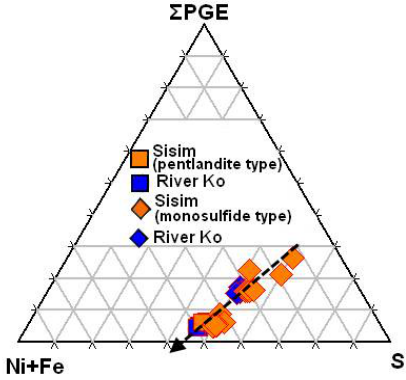
Figure 7. Variation of compositions of sulfide phases of the monosulfide and pentlandite types, which occur as inclusions hosted by placer grains of Os–Ir–(Ru) alloys from the River Sisim (this study) and the River Ko [3] in terms of ternary plot ΣPGE–Ni + Fe (+Co)–S (atomic %).